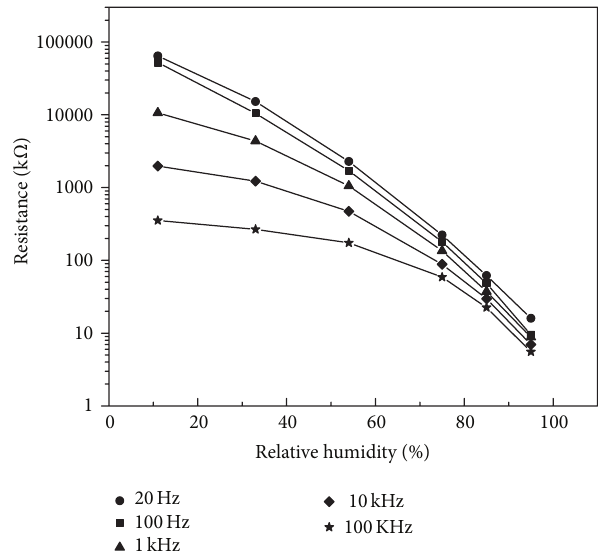
Figure 5: Resistance versus RH plots of 10 mol% La 2 O 3 doped CeO 2 nanopowders sensor at various frequencies.